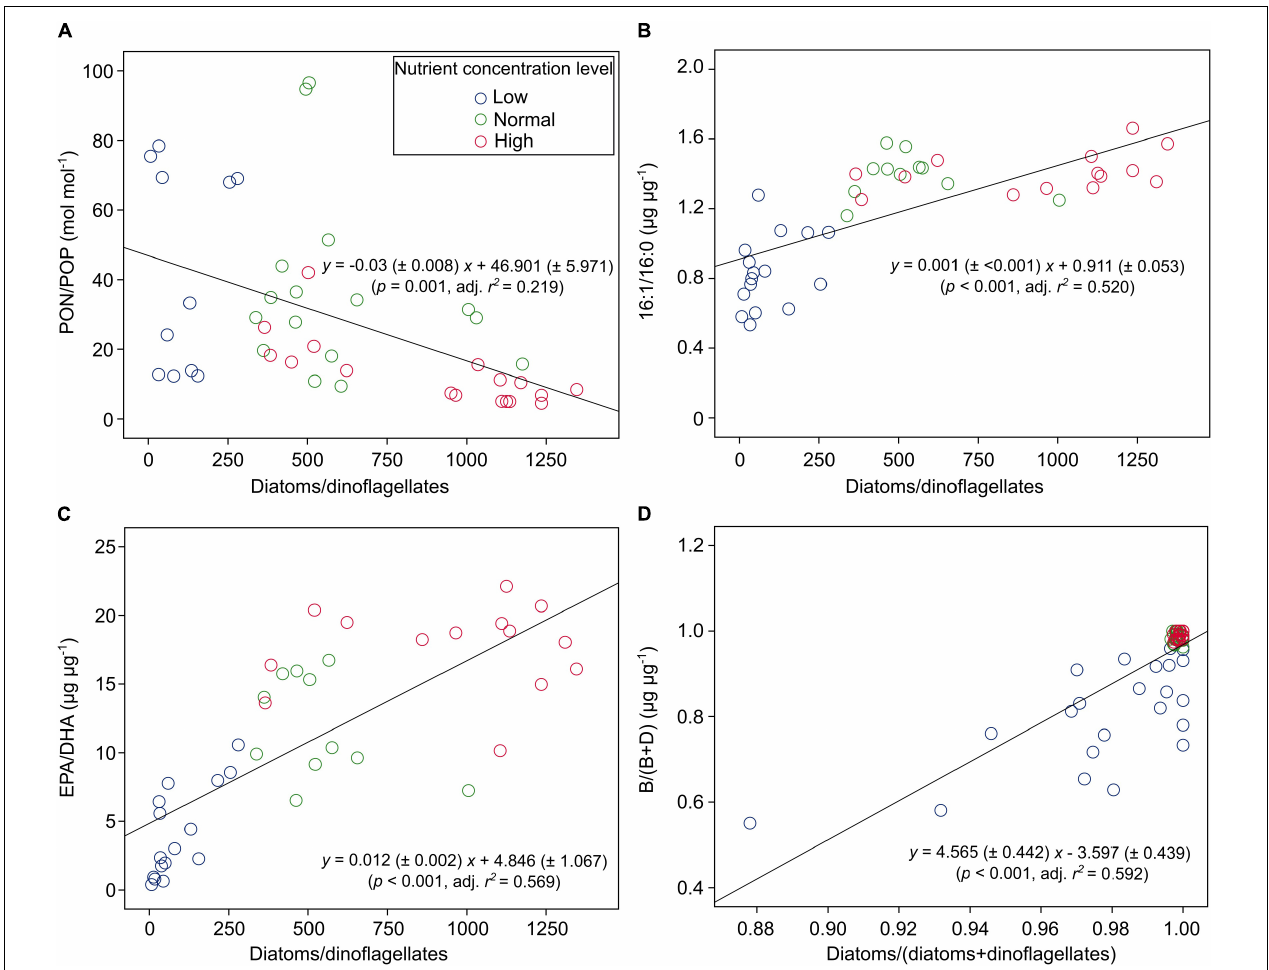
FIGURE 5 | The correlations between PON/POP (and lipid biomarker ratios) and cell density ratios of diatoms/dinoflagellates [or diatoms/(diatoms + dinoflagellates)] under three levels of nutrient concentrations over the entire ranges of temperature and N:P supply ratios in the bicultures of Phaeodactylum tricornutum and Prorocentrum minimum : (A) PON/POP, (B) 16:1/16:0, (C) EPA/DHA, and (D) the ratios of brassicasterol/epi-brassicasterol to (brassicasterol/epi-brassicasterol + dinosterol) [B/(B +